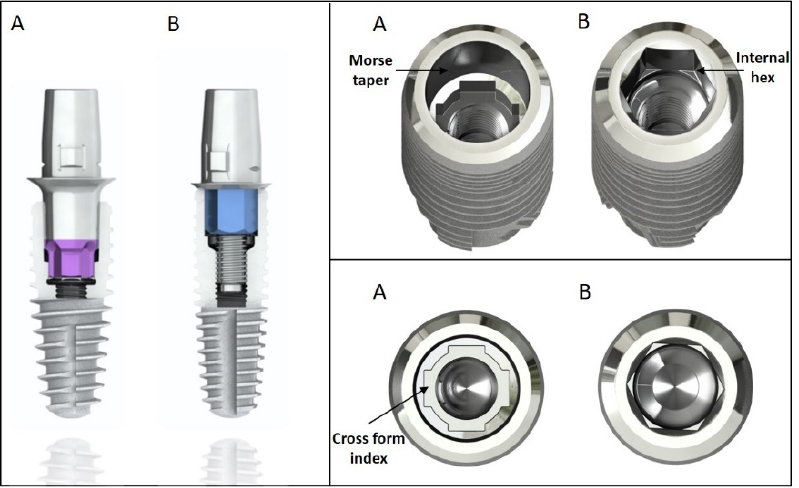
Figure 2. ( A ) Implant with an internal conical connection; ( B ) implant with an internal hexagonal connection.